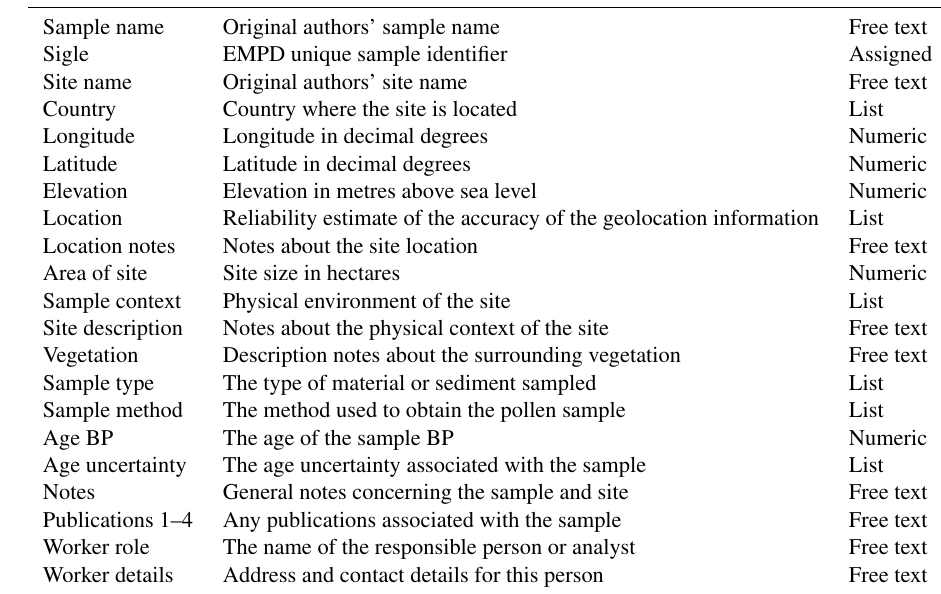
Table 1. List of metadata fields used in the